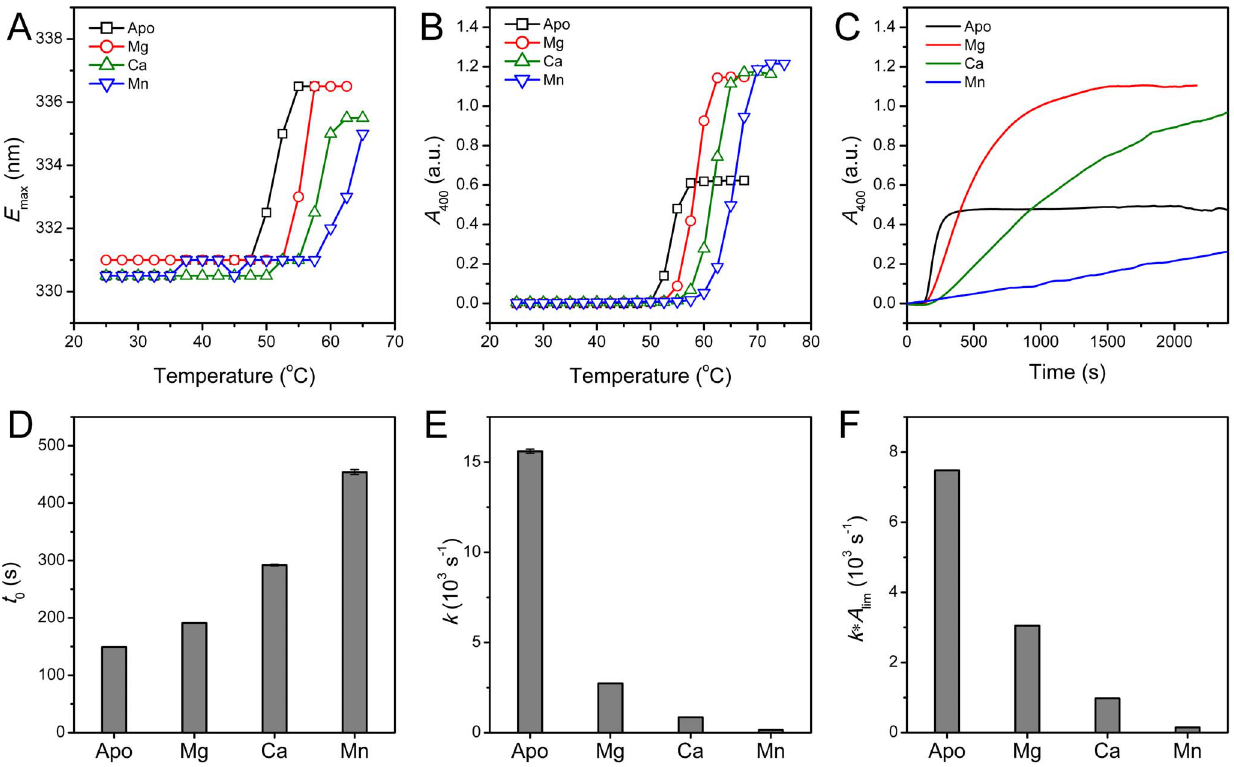
Figure 6. Effect of the divalent metal ions on CrCaf1 thermal stability. (A) Thermal denaturation of CrCaf1 in the presence or absence of divalent metal ions probed by the maximum emission wavelength ( E max ) of the intrinsic Trp fluorescence. (B) Thermal aggregation of CrCaf1 monitored by turbidity (absorbance at 400 nm). (C) Effect of 3 mM divalent metal ions on the thermal aggregation kinetics of CrCaf1. The time-course change of the turbidity was recorded by heating the protein samples at 55 u C controlled by a water-bath. The data were fitted to Eq. (1), and the kinetic parameters are presented in panels D–F. (D) The lag time t 0 . (E) The aggregation rate constant k . (F) The initial velocity of aggregation kA lim . The concentration of the protein was 0.2 mg/ml, and that of the divalent metal ions was 3 mM.